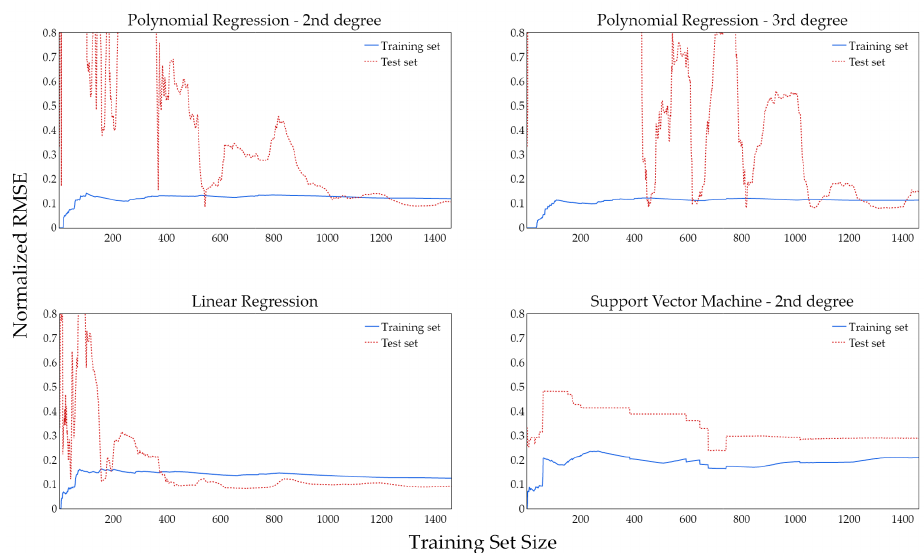
Figure 12. Learning curves of proposed models for 3rd DCT frequency component (latitude: 22.5 ◦ S, longitude: 180 ◦ E).